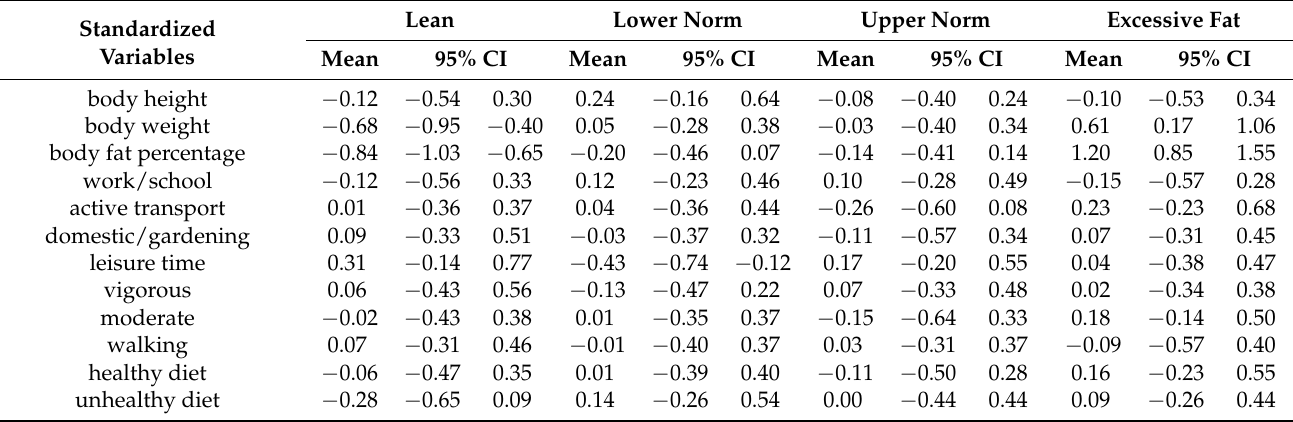
Table 1. Standardized mean values with 95% confidence intervals for variables measured in four groups of adolescents separated based on body fat percentage.